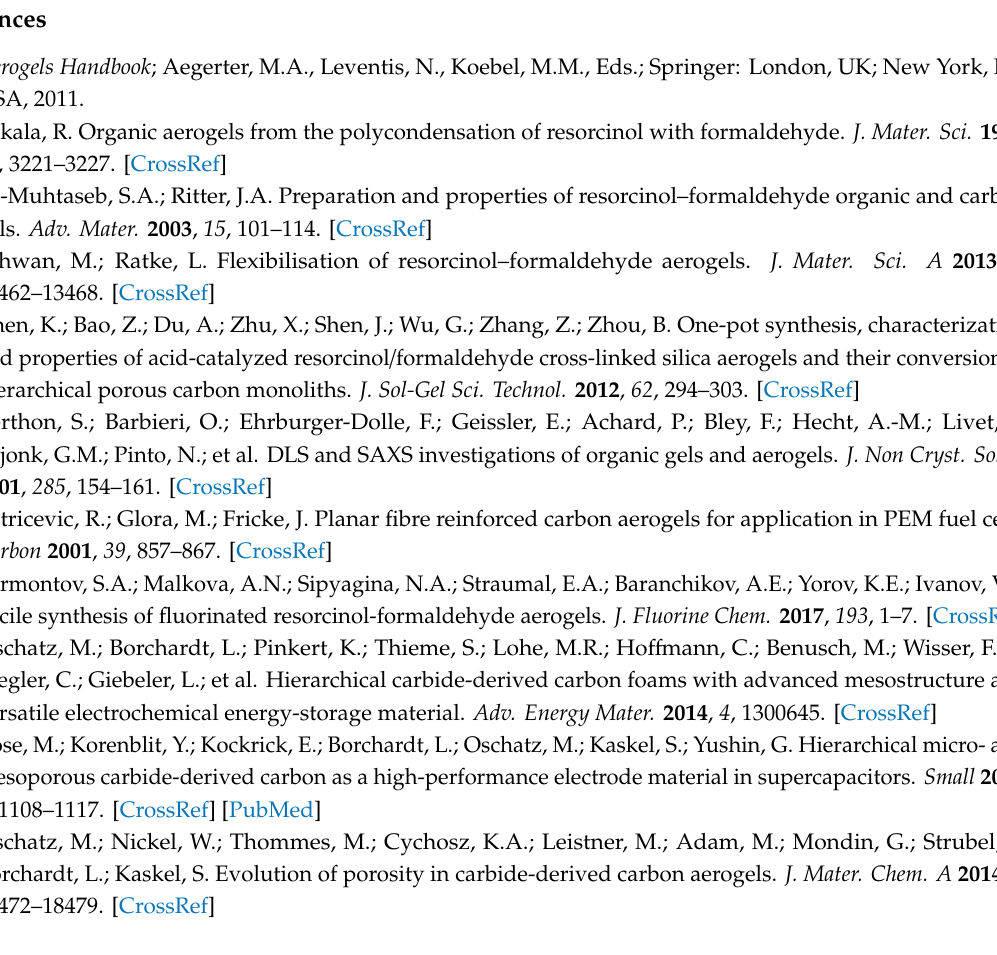
Figure S1. 1—sample, 2—wires potential electrodes, 3—wires tensioning system, 4—current electrodes, bronchial clamp, 2. The electrochemical characteristics measurements, Figure S2. Equivalent circuit for the impedance spectra of an aerogel electrode prepared by pyrolysis at 1000 and 1100 ◦ C, Figure S3. Equivalent circuit for the impedance spectra of an aerogel electrode prepared by pyrolysis at 900 ◦ C, Figure S4 Voltammograms of samples of the experimental supercapacitor electrode from RF-900 aerogel, Figure S5. Voltammograms of samples of the experimental supercapacitor electrode from RF-1100 aerogel, Figure S6. The TEM images of samples, prepared at di ff erent pyrolysis temperatures. Samples were grounded and placed on amorphous carbon substrate, Figure S7. Powder X-ray di ff raction patterns of RF-800 (down) and RF-1100 aerogels (up), Figure S8. The ATR-FTIR spectrum of RF-1100 aerogel